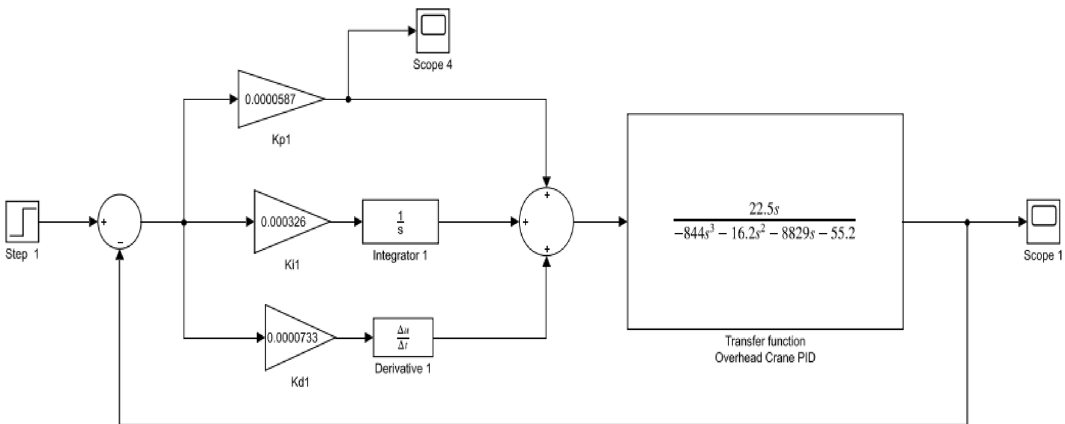
Fig. 7 Schematic diagram of PID control of overhead crane for swinging motion